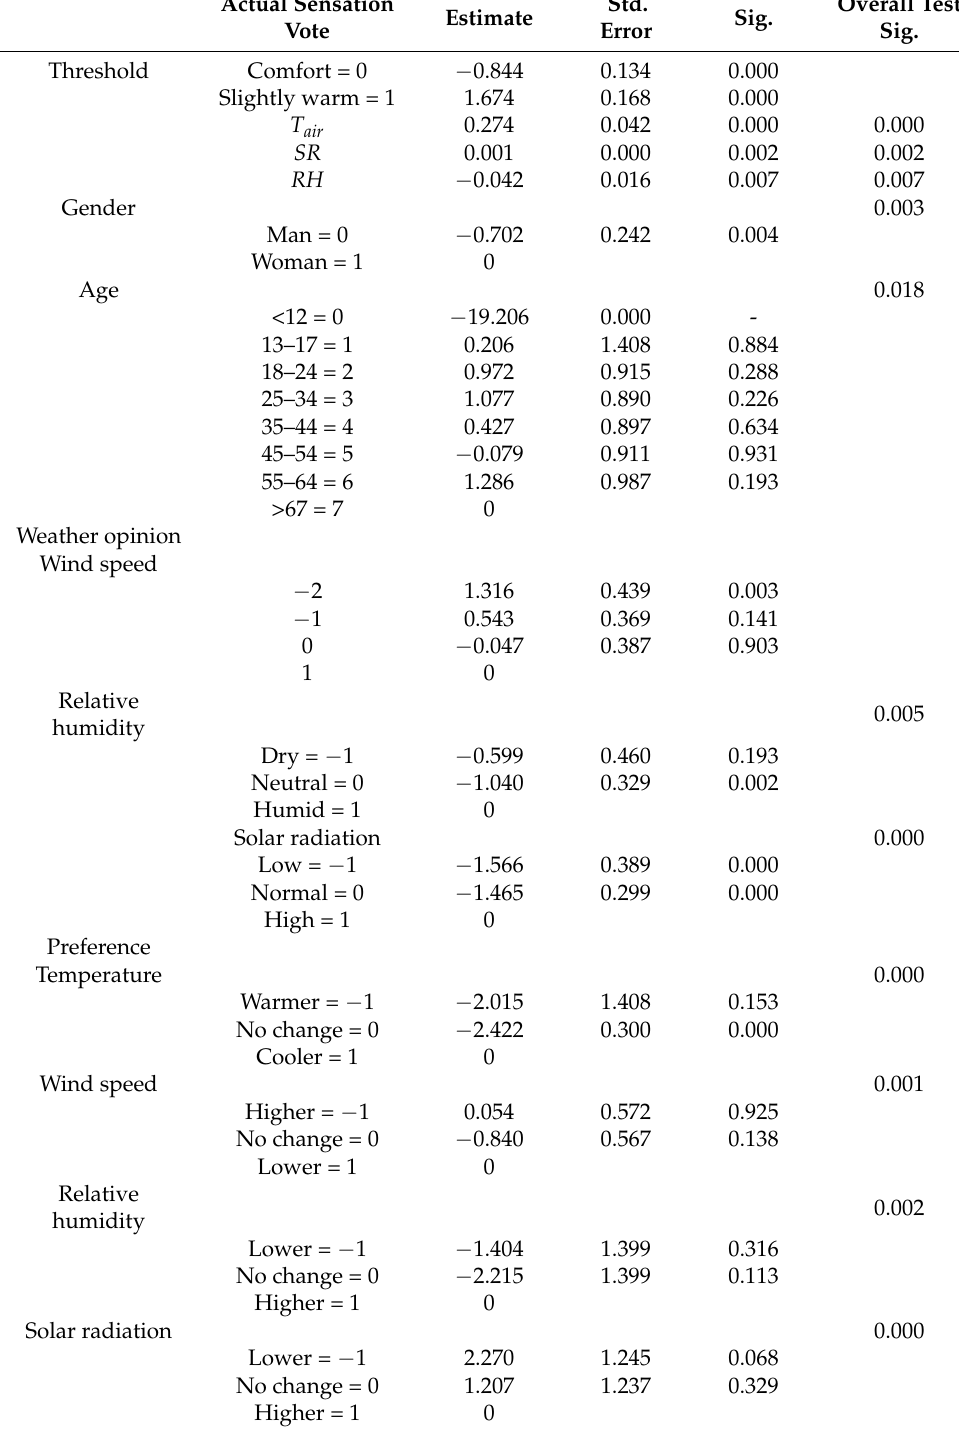
Table 11. Ordinal regression analysis for the prediction of actual sensation votes.